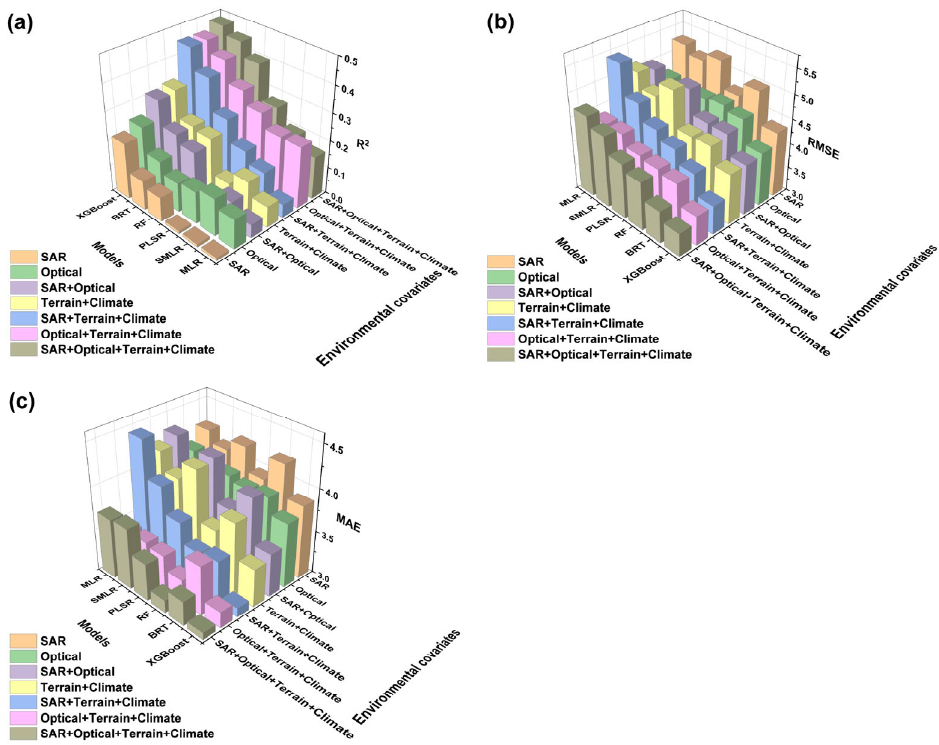
Figure 4. The R 2 , RMSE and MAE among seven covariate sets in six models for SOC prediction. ( a ) Coefficient of determination (R 2 ), ( b ) root mean square error (RMSE) and ( c ) mean absolute error (MAE).